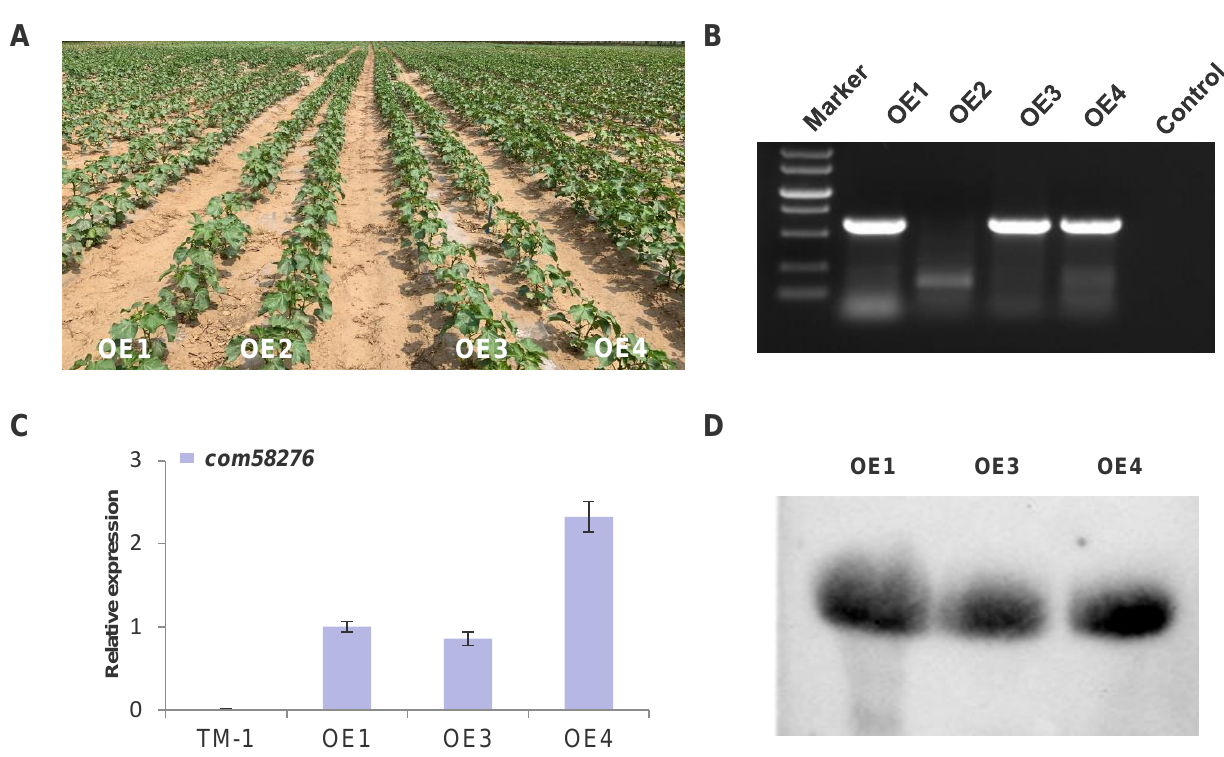
Figure 2. Overexpression com58276 cotton field phenotype and identification. ( A ) The phenotype of overexpression com58276 cotton in the field. ( B ) RT-PCR amplification results of transgenic cotton. ( C ) The qRT-PCR result of OE cotton and TM-1. ( D ) The northern blot result of OE